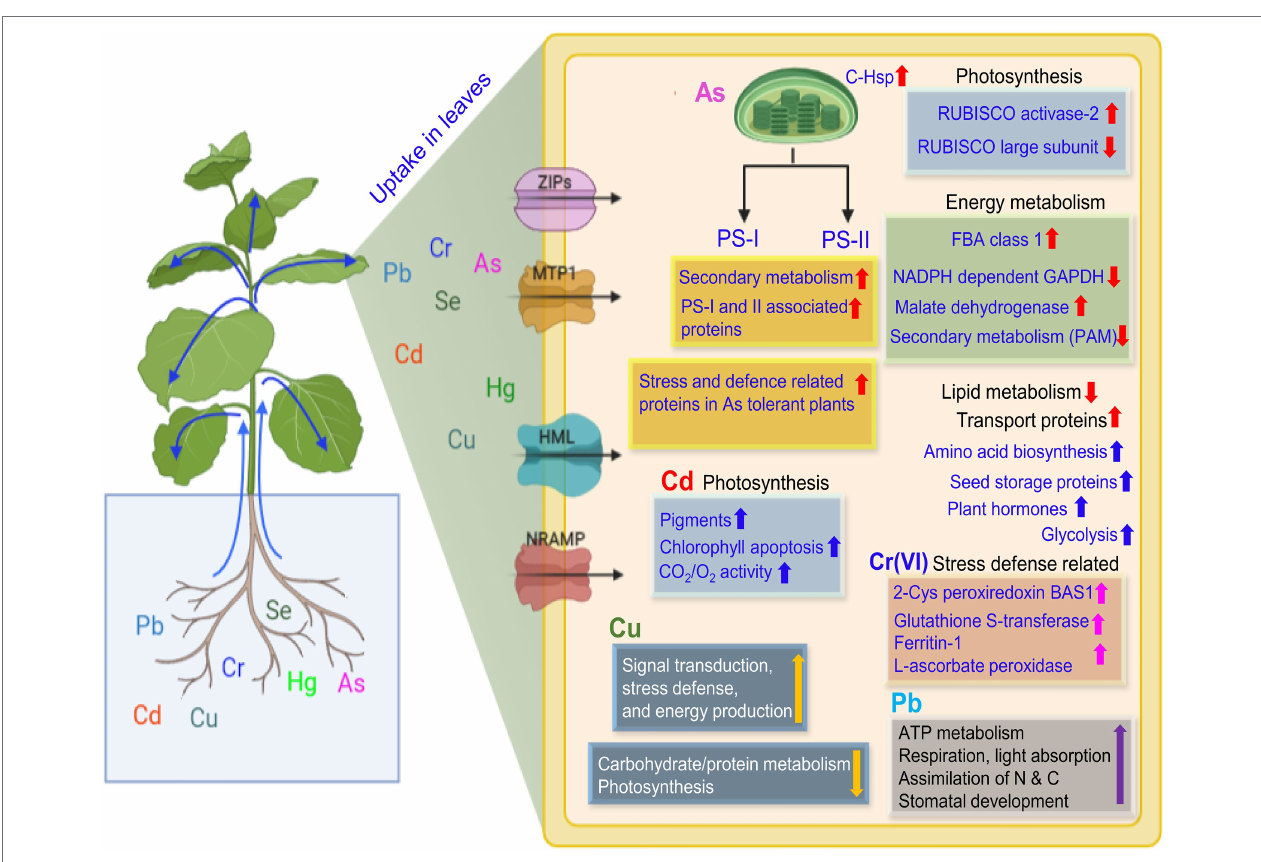
FIGURE 4 | An illustration of the uptake of potentially toxic elements and plant response in the leaves. Uptake of PTEs in plant leaf resulting in significant up- or down-regulation of several proteins as represented by up and down arrows, respectively. The fold change may vary with the metal species, exposure duration, and intercellular concentration. Up and down red arrows are for as, blue for Cd, pink for Cr(VI), yellow for Cu, and violet for Pb. Membrane-embedded channels show the metal transport inside the leaf cell. Abbreviations: RUBISCO, Ribulose bisphosphate carboxylase/oxygenase; FBA, Ructose-bisphosphate aldolase; GAPDH, Glyceraldehyde 3-phosphate dehydrogenase; PAM, Phenylalanine aminomutase; C-Hsp, Chloroplast heat shock proteins; ZIPs, zinc-iron permease; MTP1, Metal transport protein1; CDF, Cation diffusion facilitator; and NRAMP, Natural resistant associated macrophage